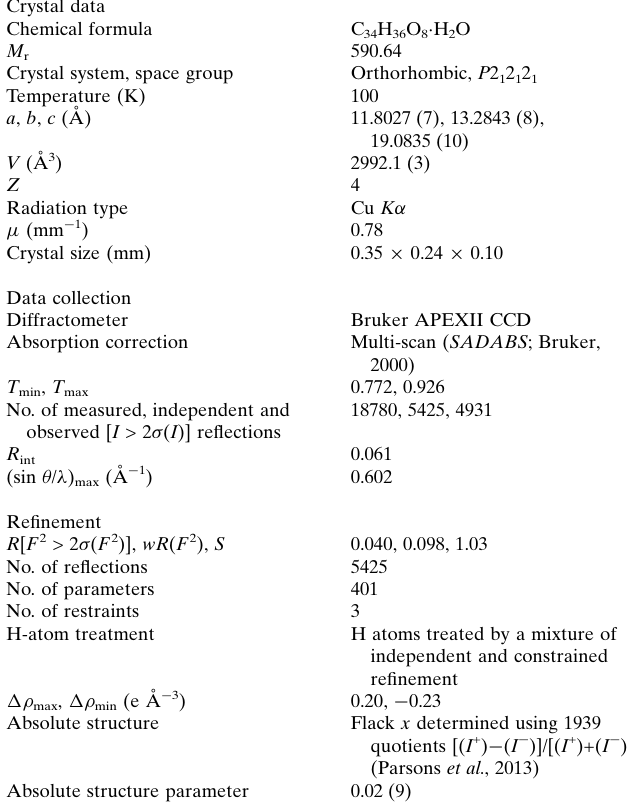
Table 2 Experimental details. Crystal data Chemical